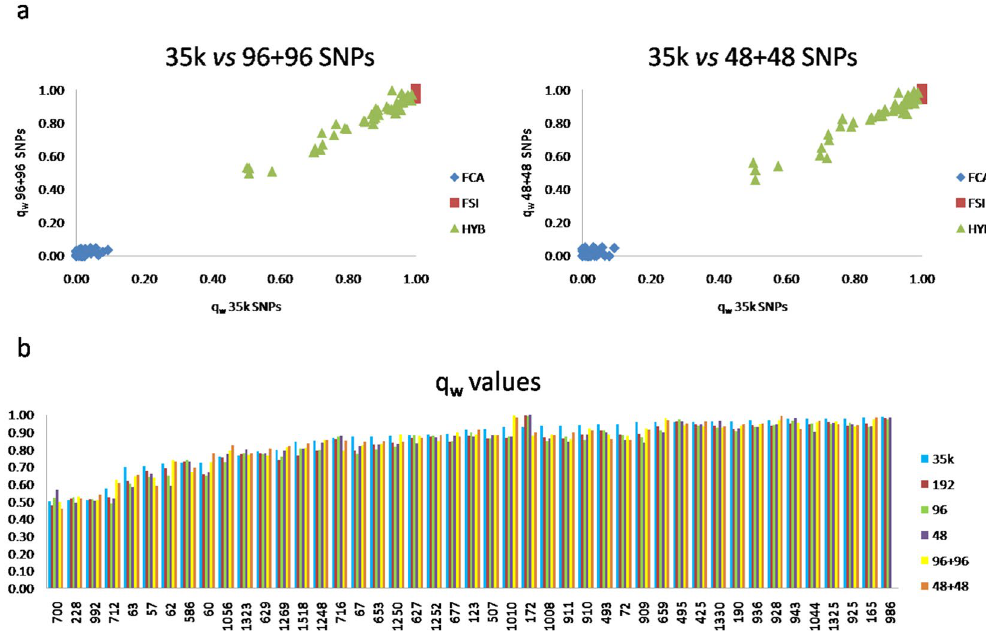
Figure 5. ( a ) Scatterplot of individual proportions of membership to the wild clusters (q w ) of 146 sampled cats (including domestic, European wild and known/putatively admixed cats), according to the assignment analyses performed in Admixture. Individual’s wild memberships estimated with the combined reduced SNP panel set (96 + 96 and 48 + 48 AIM SNPs, informative for both admixture and genetic structure analyses) were strictly correlated with those obtained with the 35k LD-pruned SNP panel set. ( b ) Wildcat ancestry proportions of known hybrids and putative admixed cats (n = 45) inferred in Admixture with the initial 35k LD-pruned SNP panel set in addition to the reduced (192, 96 and 48) and combined (96 + 96 and 48 + 48) SNP panel sets. All the reduced marker panels did not reduce the assignment power to the parental